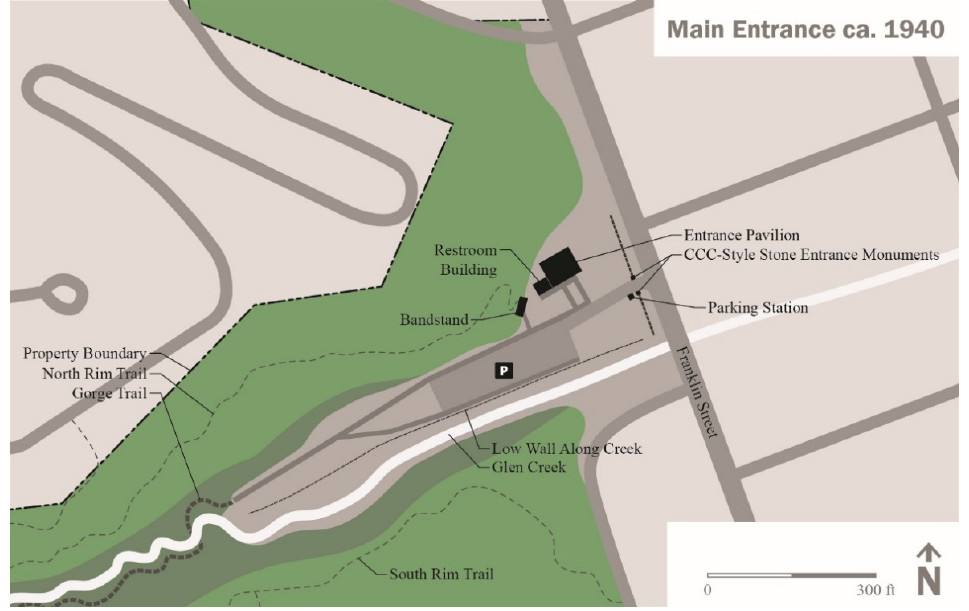
Figure 14. Plan of Main Entrance, ca. 1940, by author.